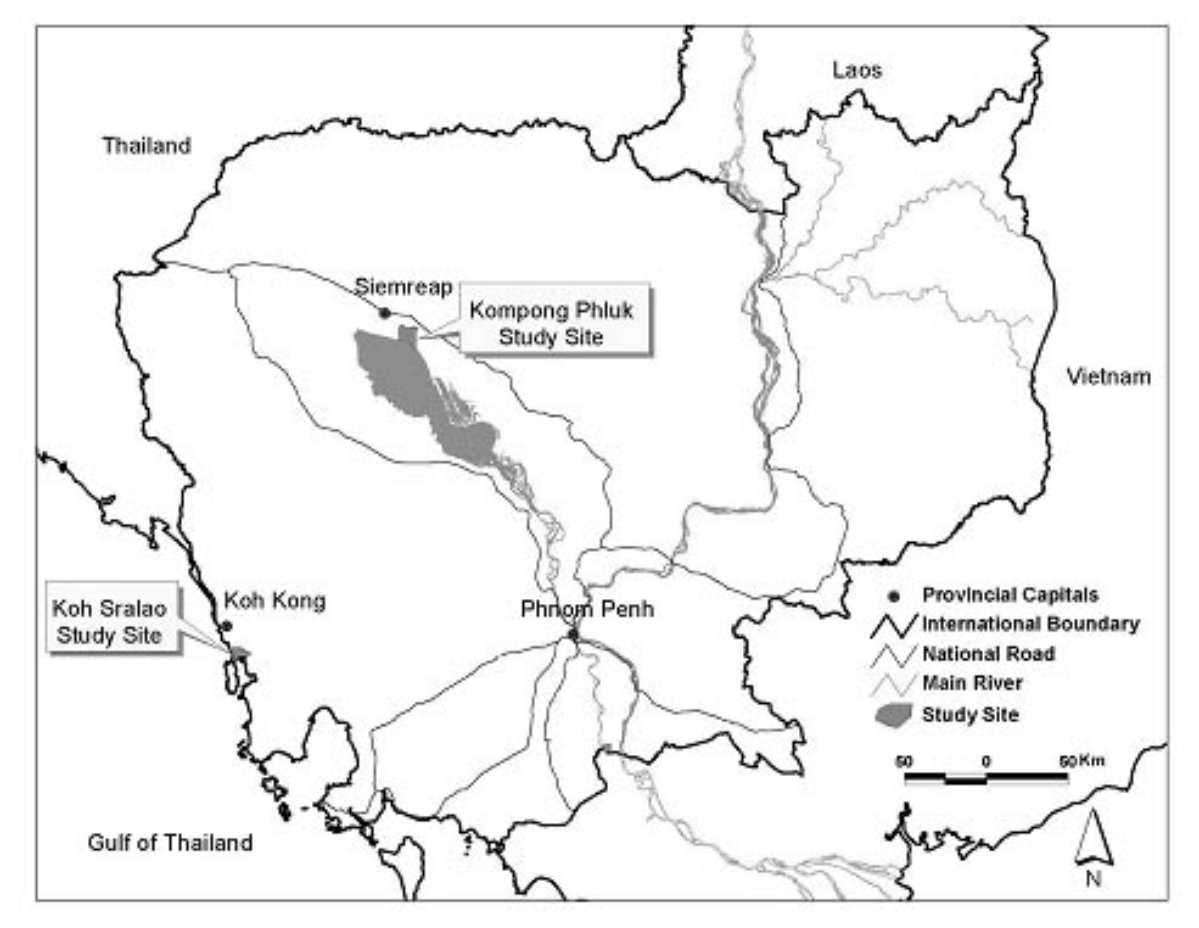
Fig. 1. The two research areas,